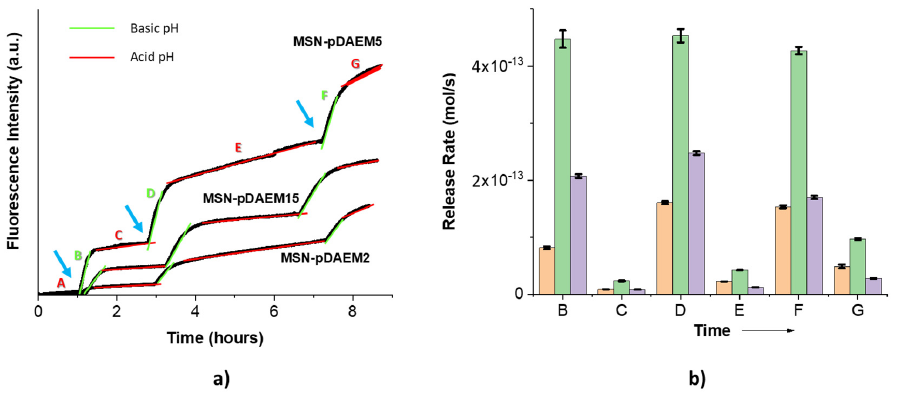
Figure 6. ( a ) Fluorescence intensity of SRB released from SRB-loaded MSN-pDAEM2, MSN-pDAEM5, and MSN- pDAEM15 in PBS (solid black lines). The released SRB diffuses across the dialysis membrane and is measured in the bottom compartment of the cuvette. The system is followed continuously for 8.3 h ( λ exc = 566 nm, λ em = 589 nm). The blue arrows indicate additions of base solution in the top compartment of the cuvette, green lines (zones B, D, and F), and red lines (zones C, E, and G) indicate basic and acid pH periods in the top compartment, respectively. ( b ) Diffusion rates of SRB released from MSN-pDAEM2 (orange columns), MSN-pDAEM5 (green columns), and MSN-pDAEM15 (purple columns); B–G indicate the time intervals shown in ( a ). Time interval A corresponds to the desorption of SRB remaining at (or close to) the particle surface after the cleaning procedure.